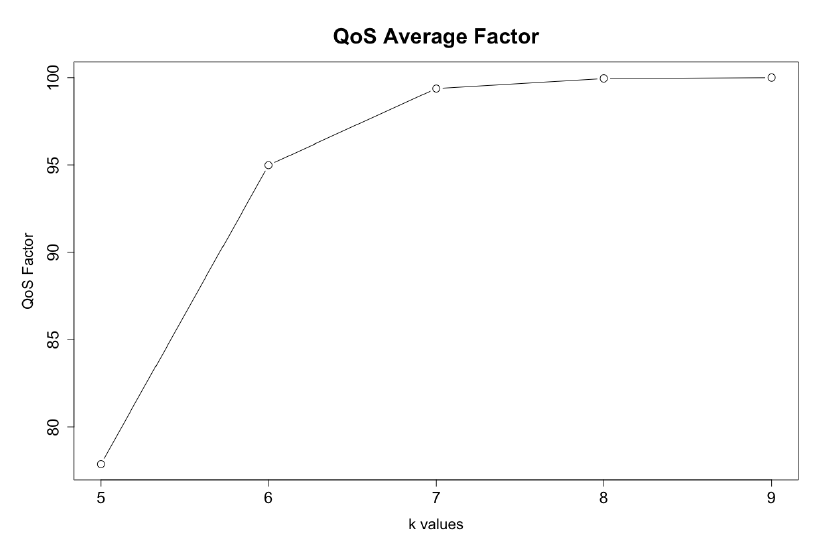
Figure 7. QoS average factor for each k